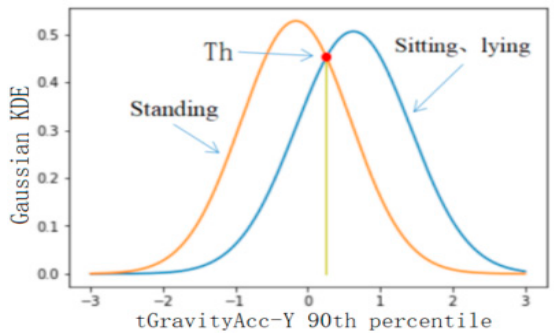
Figure 9. Probability distribution of standing, sitting, and lying.